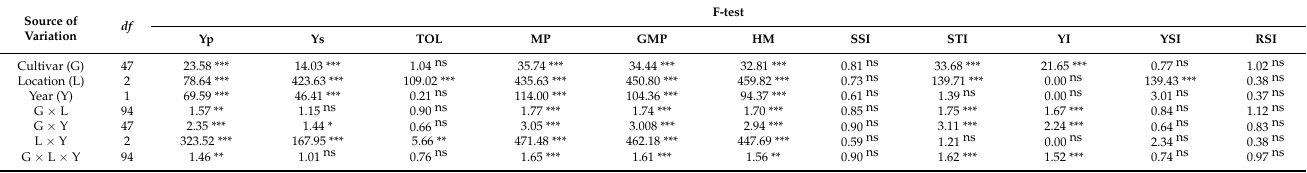
Table 2. Summary of the ANOVA (significance of the F-test) for the grain protein content and stress screening indices. Sourceof Variation